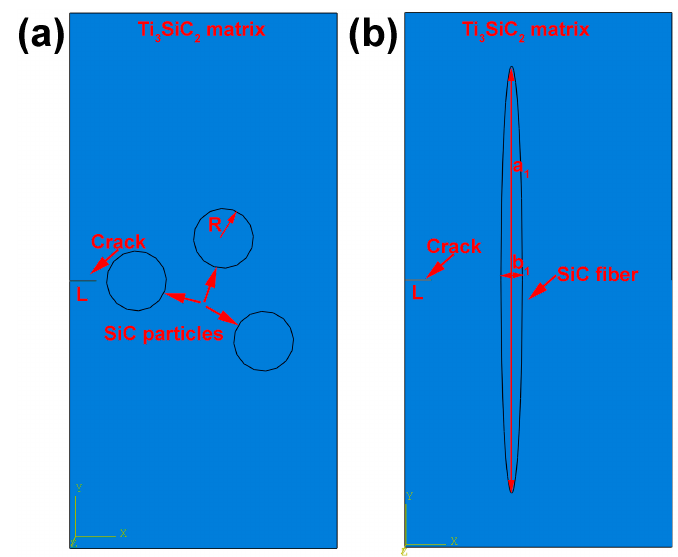
Figure 7. 3D finite element model (3D-FEM) of SiC-reinforced Ti 3 SiC 2 MAX phase with a crack on the left, ( a ) SiC particle ( b ) SiC fiber with a length–diameter ratio is 20:1.